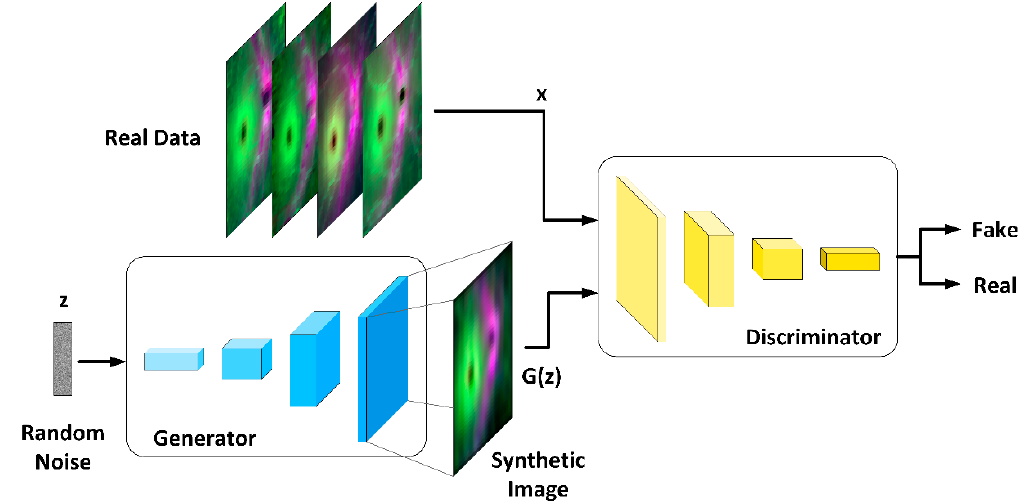
Figure 4. GAN framework workflow.